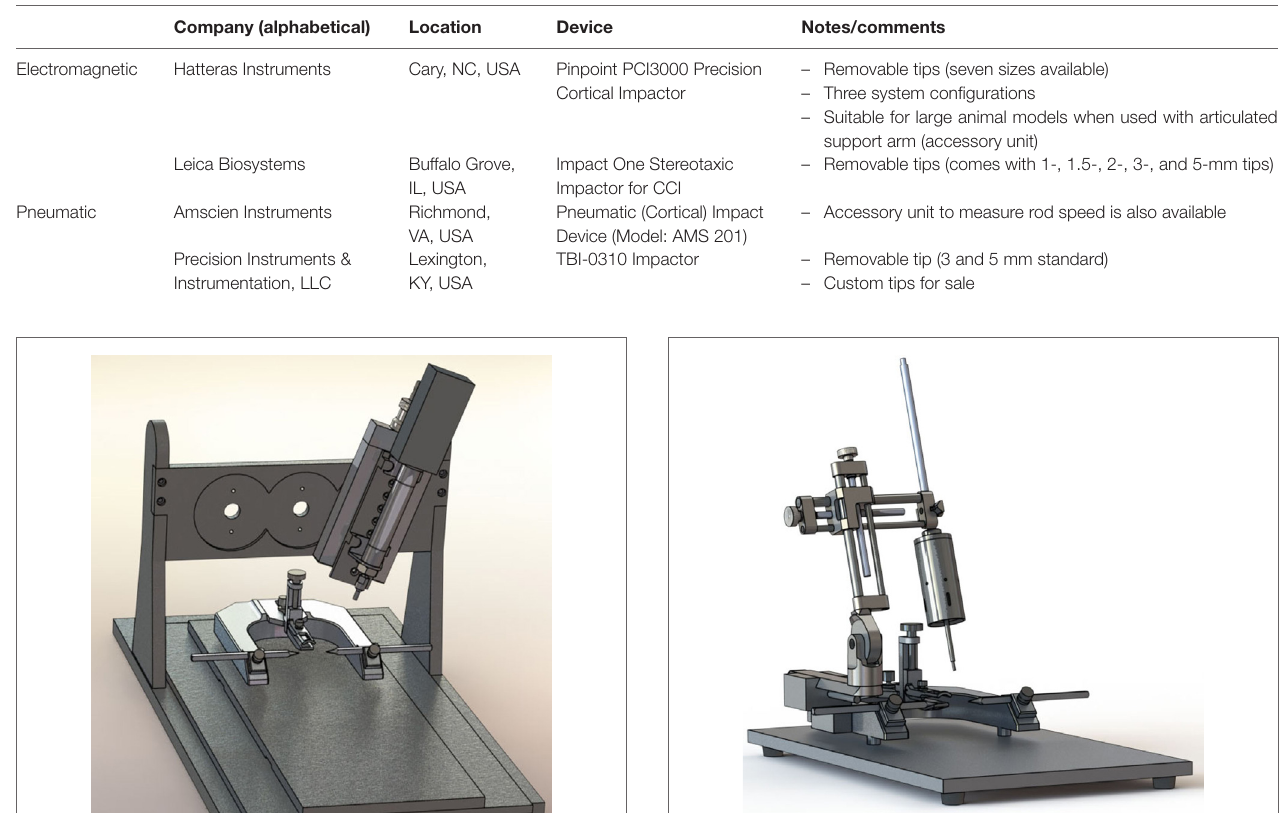
TABLe 1 | Summary of CCi types and commercial